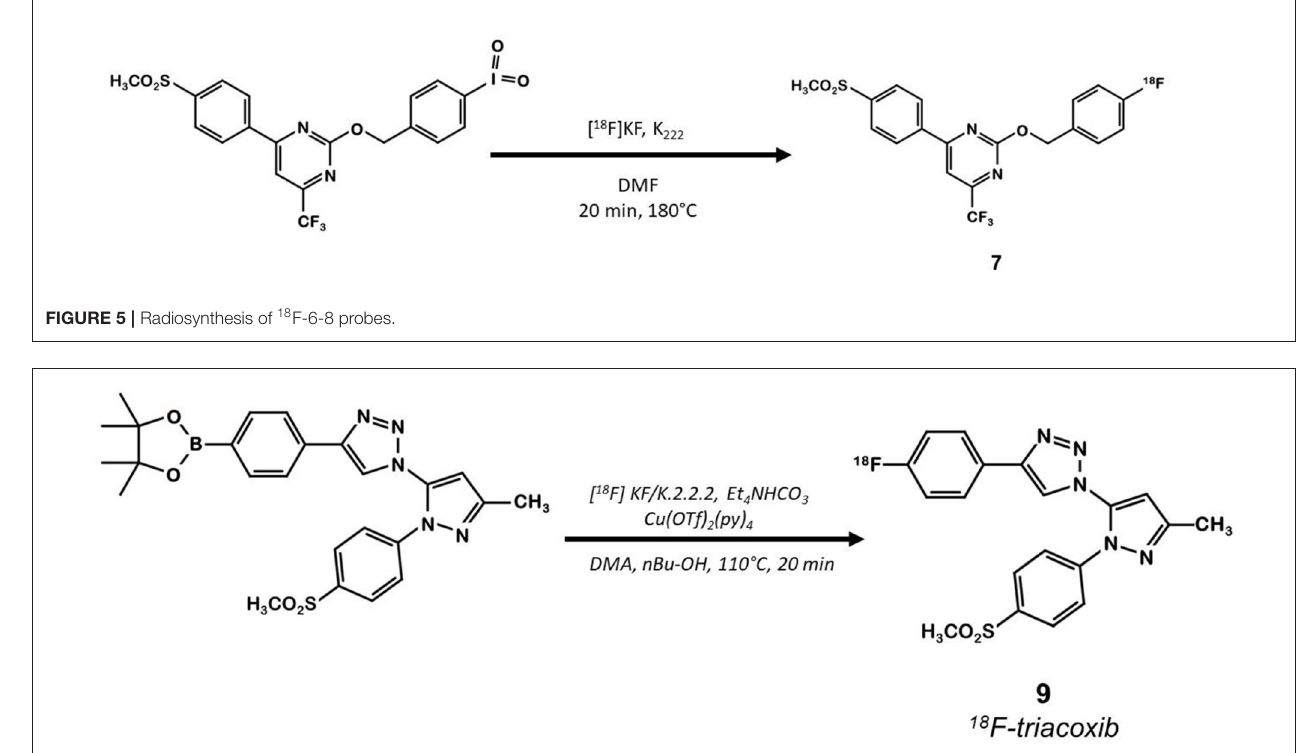
FIGURE 6 | Radiosynthesis of 18 F-Triacoxib 9.